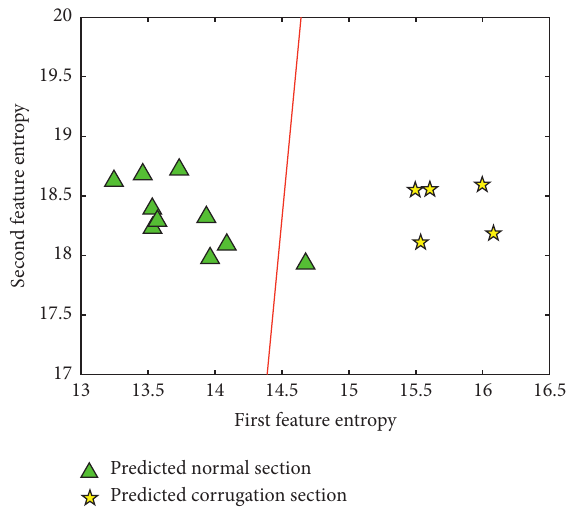
Figure 11: The prediction results using the trained Support Vector Machine classifier.